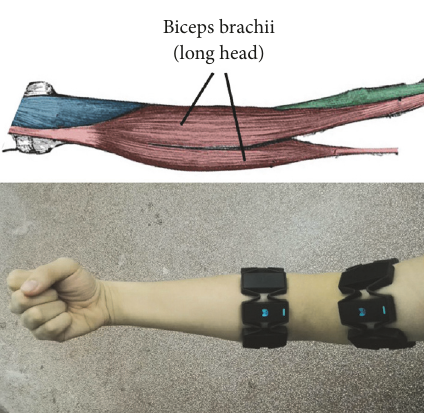
Figure 4: Demonstrator wearing the MYO armband.